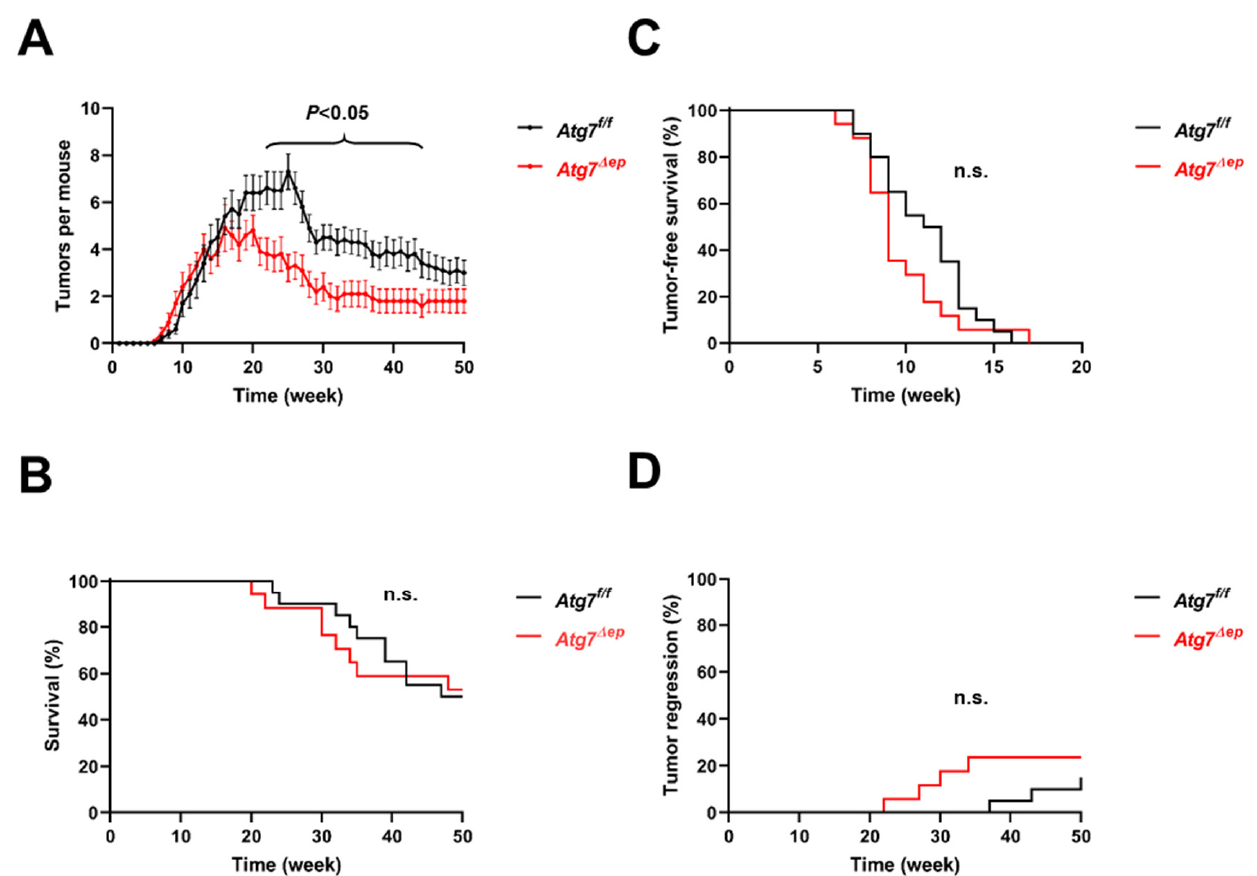
Figure 2. Deletion of Atg7 leads to lower numbers of tumors per mouse in the two-step chemical carcinogenesis model. ( A ) Atg7 f/f ( n = 20) and Atg7 ∆ ep ( n = 17) mice were treated with DMBA in week 0 and with TPA in the subsequent 25 weeks. The mean number of tumors per mouse is plotted over time. Error bars indicate standard error of the mean (SEM). For mice that died, the final tumor number before death was kept until week 50. The difference between Atg7 f/f and Atg7 ∆ ep was significant ( p < 0.05, unpaired t -test) in weeks 21–44. p < 0.01 in weeks 22, 25–29, and 31–35. ( B ) Survival of mice is shown in a Kaplan–Meier plot. Differences were not significant (n.s.). ( C ) Tumor-free survival of mice is shown in a Kaplan–Meier plot. Differences were not significant. ( D ) Tumor regression was defined as the absence of tumors until week 50 in mice that previously had at least one tumor. The percentage of mice in which tumors regressed is shown over time. Differences were not significant.